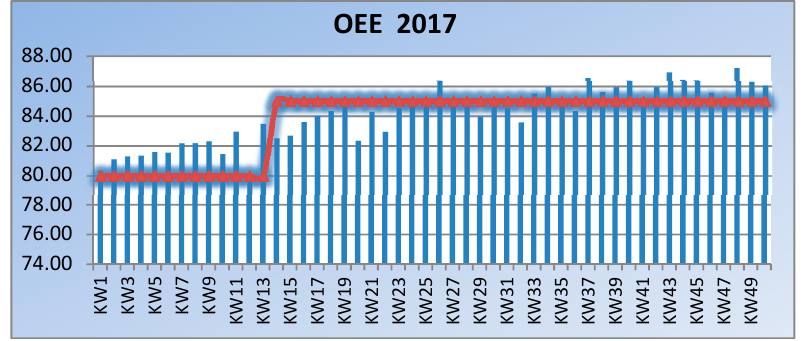
Figure 8. The evolution of the OEE in 2017 compared to the proposed objective.